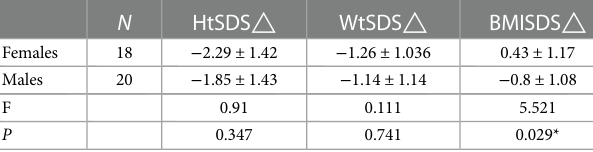
TABLE 3 45,X/46,XY mosaicism female and male group height, weight, BMI levels.